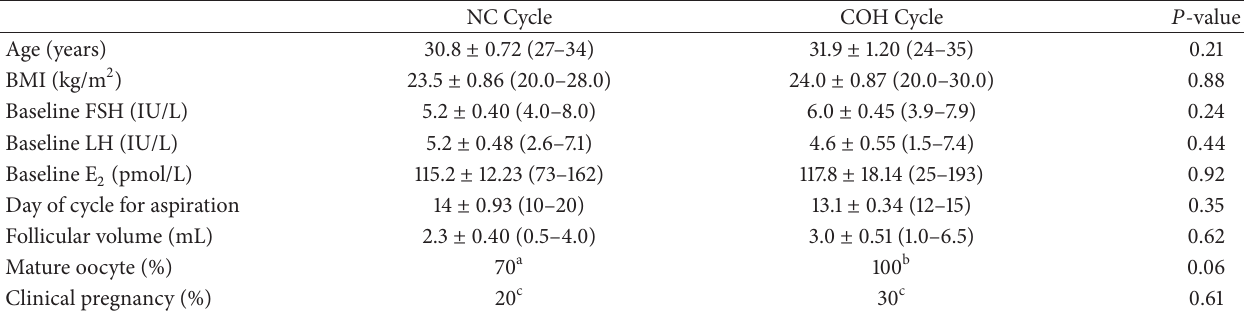
Table 1: Participant and cycle demographics in MNC and COH